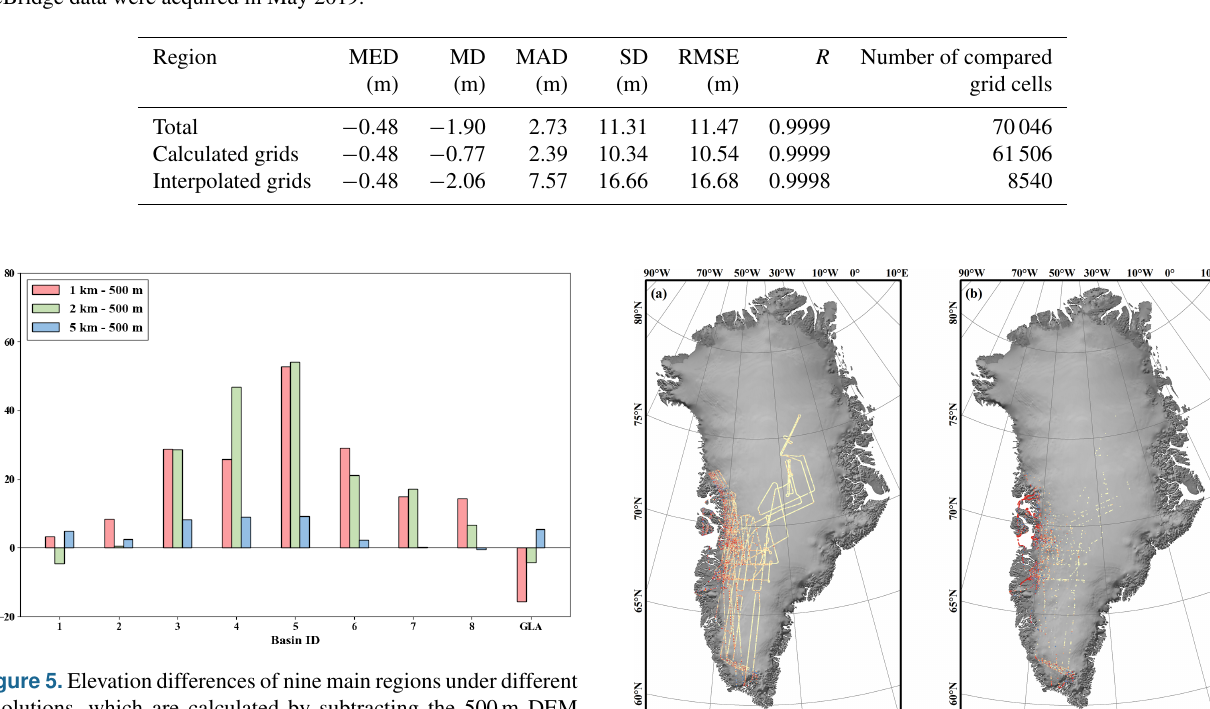
Table 2. Elevation differences between the ICESat-2 DEM and IceBridge data for all of Greenland and the calculated and interpolated grids. IceBridge data were acquired in May 2019.